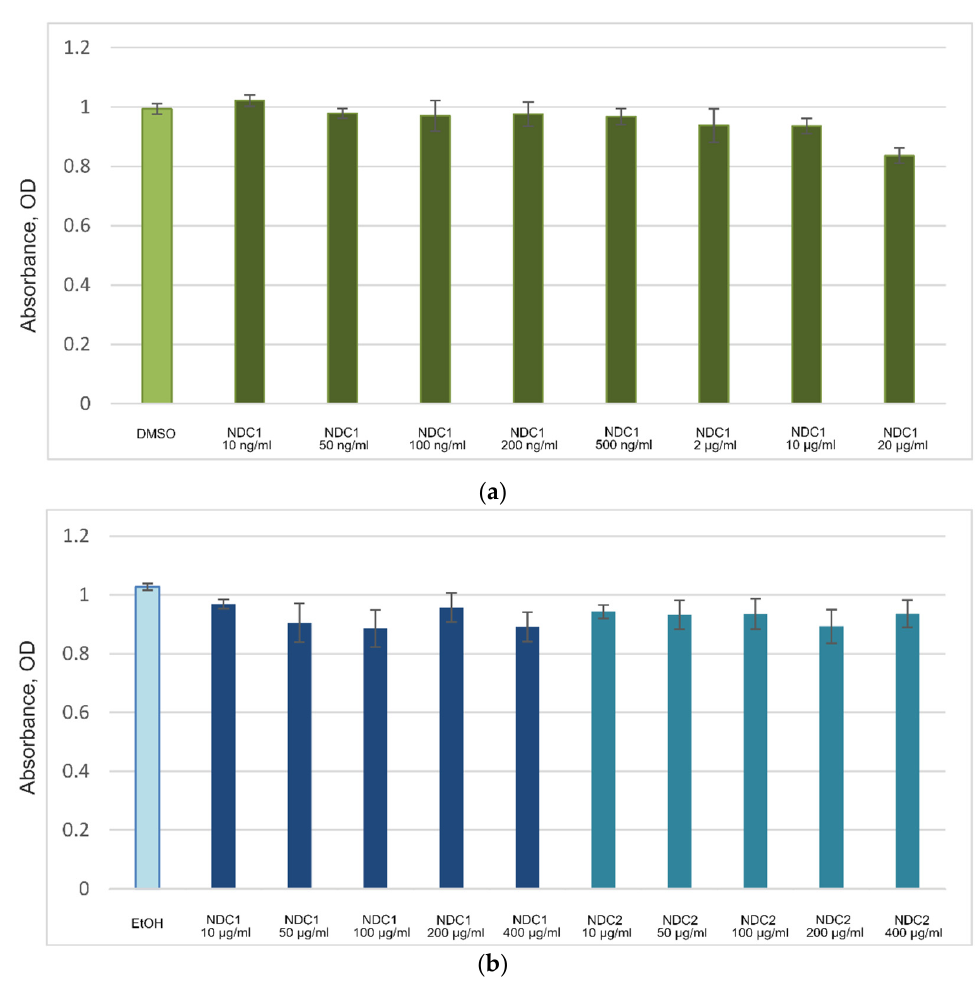
Figure 3. NDC effect on cell proliferation, data for different concentrations. ( a ) NDC1 re-suspended in DMSO. DMSO—solvent control. ( b ) NDC1 and NDC2 re-suspended in ethanol. EtOH—solvent control.